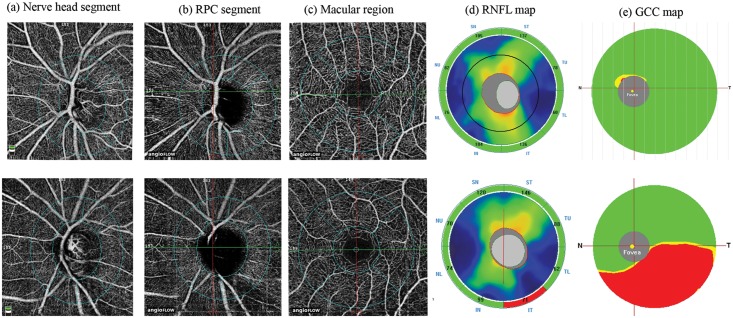
Case examples.Nerve head segment (a), radial peripapillary capillary, RPC segment (b) and macular (c) optical coherence tomography angiography scans of a normal eye (top panel) and an eye with glaucoma (bottom panel). The figure also shows the retinal nerve fiber layer, RNFL (d) and ganglion cell complex, GCC (e) maps of the two eyes. Vessel loss in the eye with glaucoma can be noted in the inferotemporal peripapillary region correlating with the RNFL loss seen on the RNFL map.